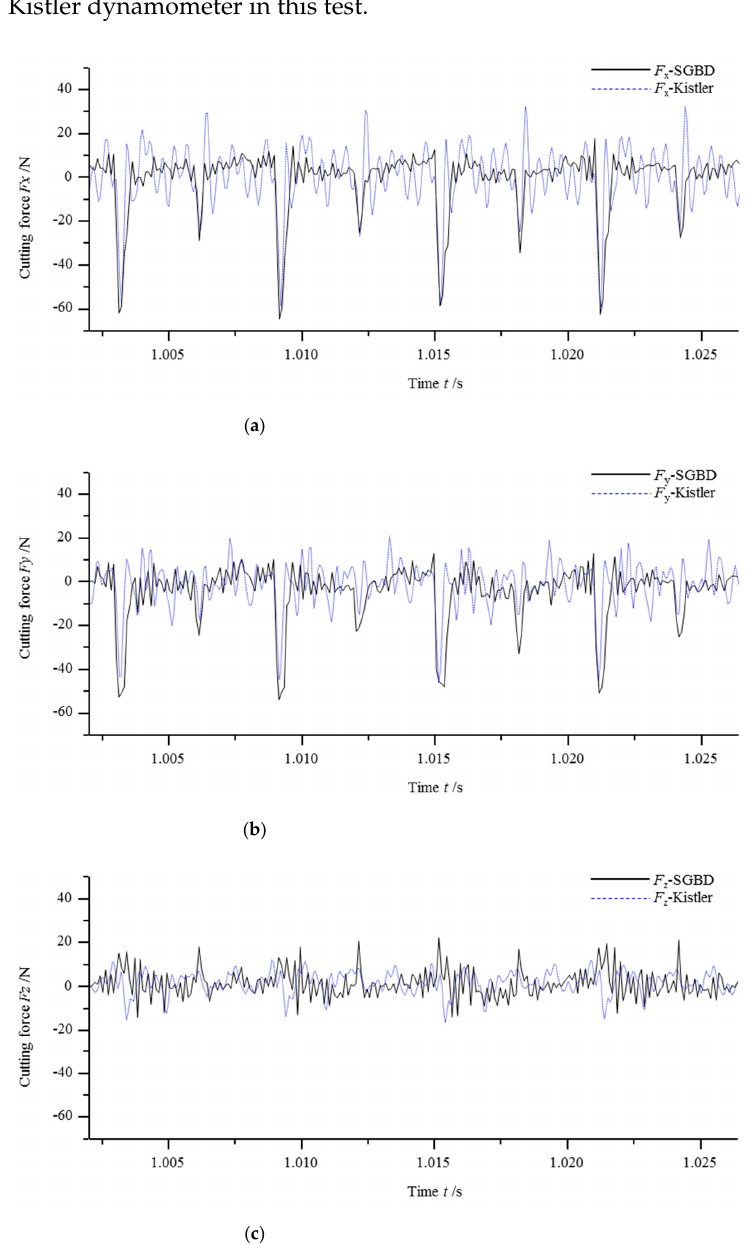
Figure 9. Cutting force signals obtained by strain-gauge-based dynamometer (SGBD) and Kistler (10,000 r/min), ( a ) cutting force signals in X direction Fx ( b ) cutting force signals in Y direction Fy ( c ) cutting force signals in Z direction